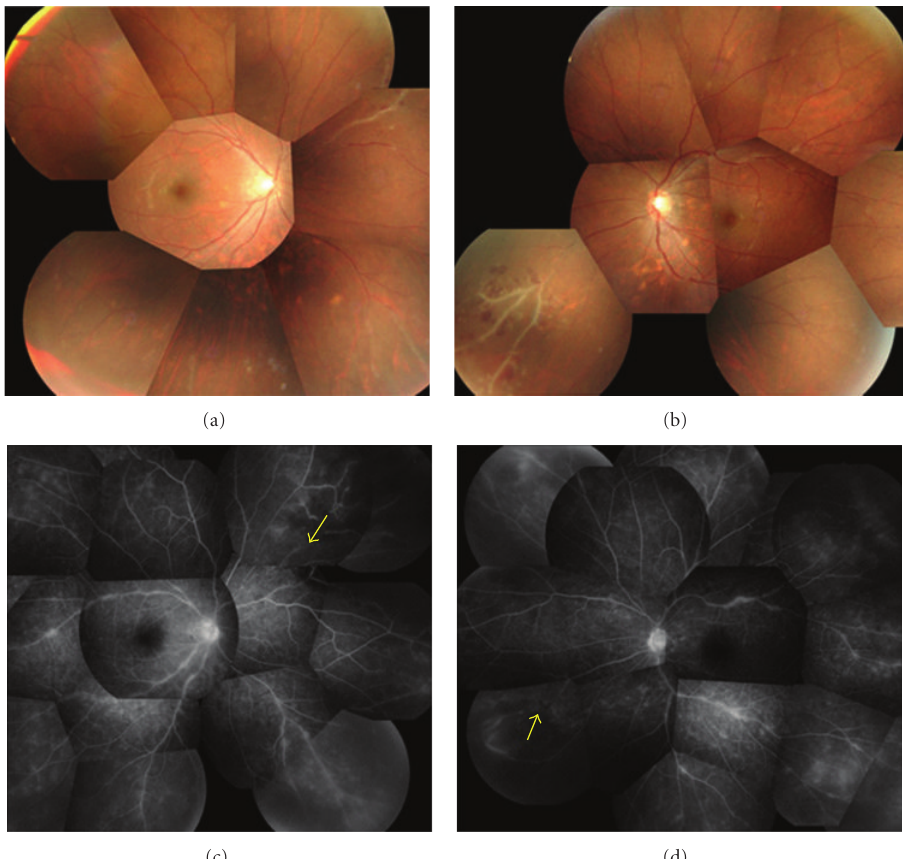
Figure 1: Composite photographs of the fundus and fluorescein angiograms of a patient with ocular sarcoidosis with an infarct in the medulla oblongata. (a) and (b) Infiltrates and ischemic areas can be seen. (c) and (d) Fluorescein angiograms of right and left eyes showing areas of nonperfusion (arrow) in both